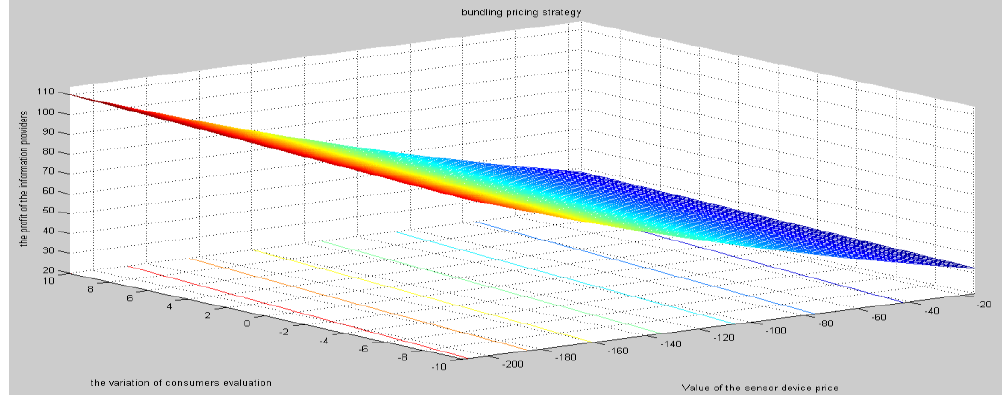
Figure 2. Profit  sb with bundling pricing strategy